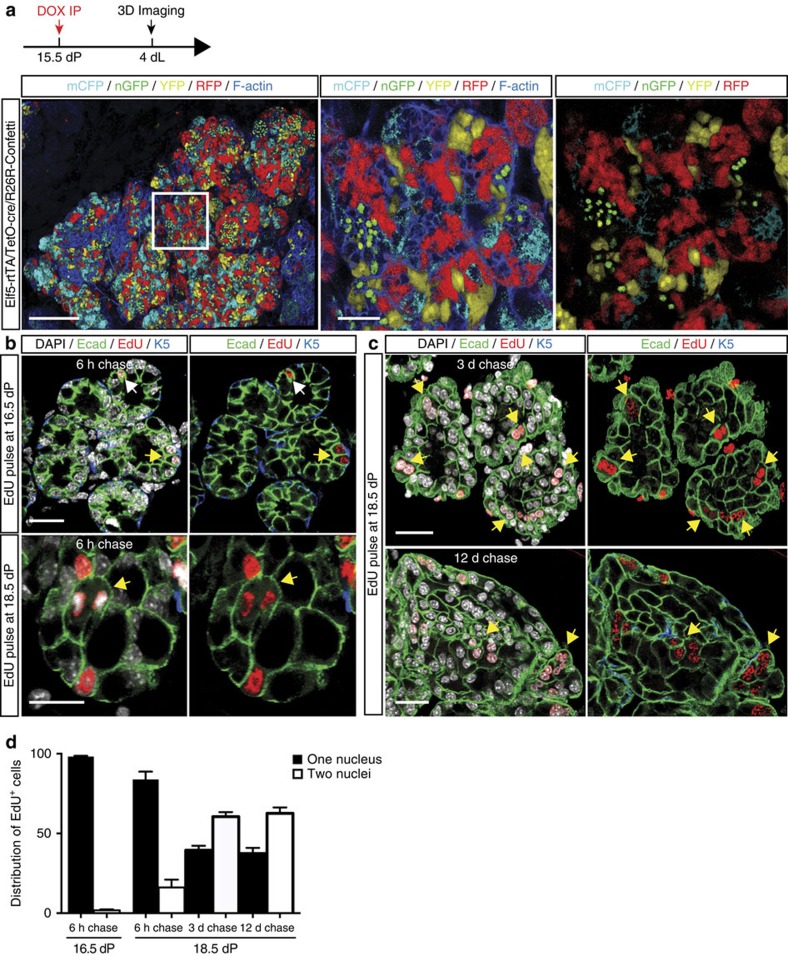
Binucleated cells are generated by failed cytokinesis and not by cell fusion.(a) Whole-mount 3D confocal image of a ductal portion from a representative Elf5-rtTA/TetO-cre/R26R-Confetti mouse. Elf5-rtTA/TetO-cre/R26R-Confetti mice were injected with doxycycline (DOX) at 15.5 days of pregnancy and analysed at 4 dL. Fusion was evaluated by determining whether cells express more than one colour. The whole-mount was labelled for F-actin (blue). Middle and right panels show optical sections from the selected region in the left panel. No multi-coloured cells were observed, indicating that cell fusion was not involved in the formation of binucleated cells (n=4 mice). Scale bars: 200 μm (whole-mount); and 50 μm (optical sections). (b) Optical section presented with (left) and without (right) DAPI staining from large whole-mounts of mammary glands from mice chased for 6 h after EdU injection at 16.5 dP (top) or 18.5 dP (bottom). Glands were stained for DAPI (white), EdU (red), Keratin 5 (blue) and E-cadherin (green). In the top panels, EdU+ cells contain only one nucleus; white arrow depicts a cell in S/G2 phase and the yellow arrow points to two cells that appear to have just undergone division. In the bottom panels, the yellow arrow depicts a binucleated cell. (c) Optical sections from whole-mounts of mammary glands isolated from mice injected with EdU at 18.5 dP and chased for 3 days (top) or 12 days (bottom). Yellow arrows depict binucleated cells that retain EdU. The whole-mounts were labelled for DAPI (white), E-cadherin (green), EdU (red) and K5 (blue). Scale bars: 20 μm (n=3 mice for each experiment). (d) Bar graph showing the percentage of EdU+ cells for luminal cells with either one or two nuclei chased for 6 h after EdU injection at 16.5 dP or chased for 6 h, 3 days or 12 days after EdU injection at 18.5 dP (n=3 mice per time-point). Error bars represent mean±s.e.m.